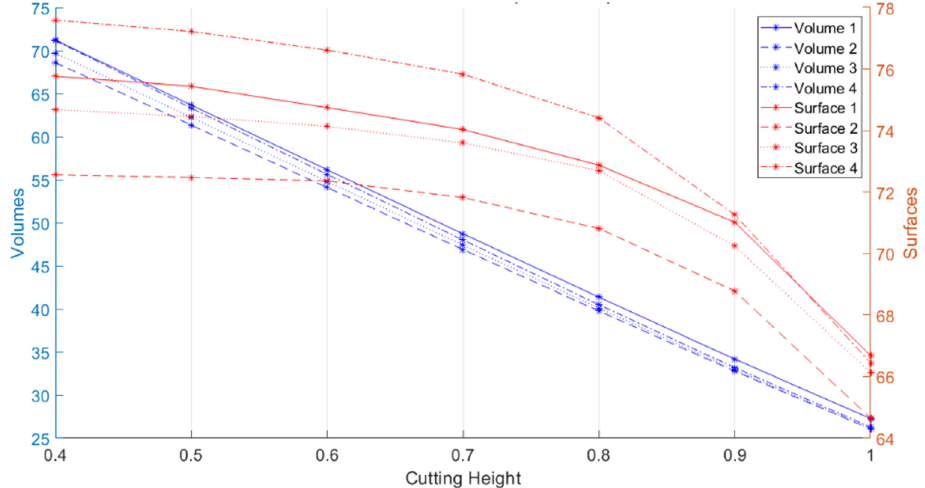
Figure 7. The absolute variation of volume (m 3 ) and surface area (m 2 ) of four vineyard rows with imposed cutting heights (MATLAB elaboration) in 2019.